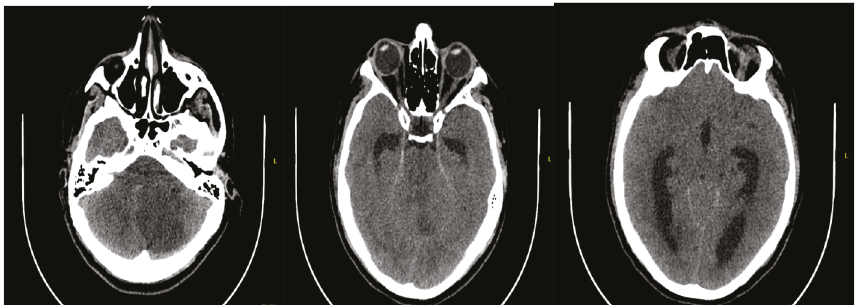
Figure 1: Simple skull tomography. (a). Infarction in the left cerebellar hemisphere. (b). Collapse of the fourth ventricle and hydrocephalus. (c). Dilation of the third ventricle and lateral